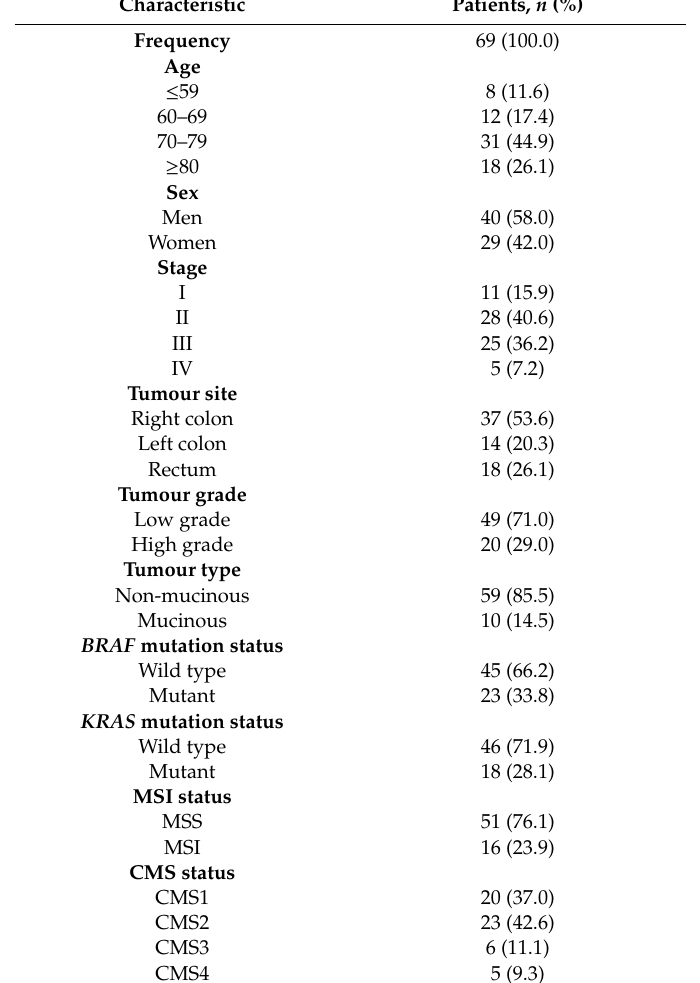
Table 1. Clinicopathological and molecular characteristics of study